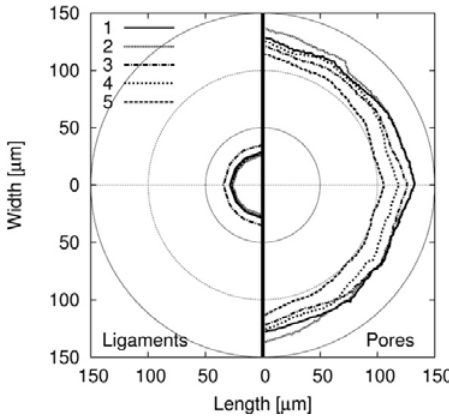
Figure 2. Microstructure ellipses based on five different images of MF-50.